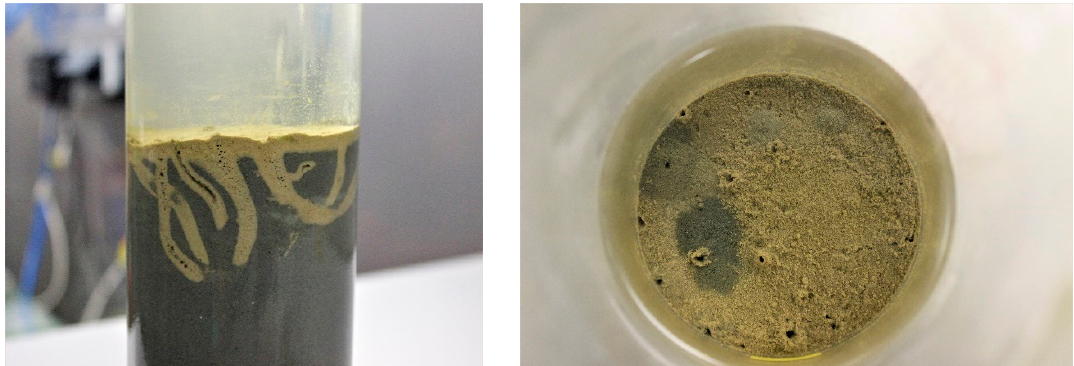
Figure 6. The bioturbation effects of chironomid larvae, evident in sharp contrast between the light-brown oxidized surface and burrow sediment, and black chemically reduced subsurface sediment (photo by A. Ma č i ū t ė ).